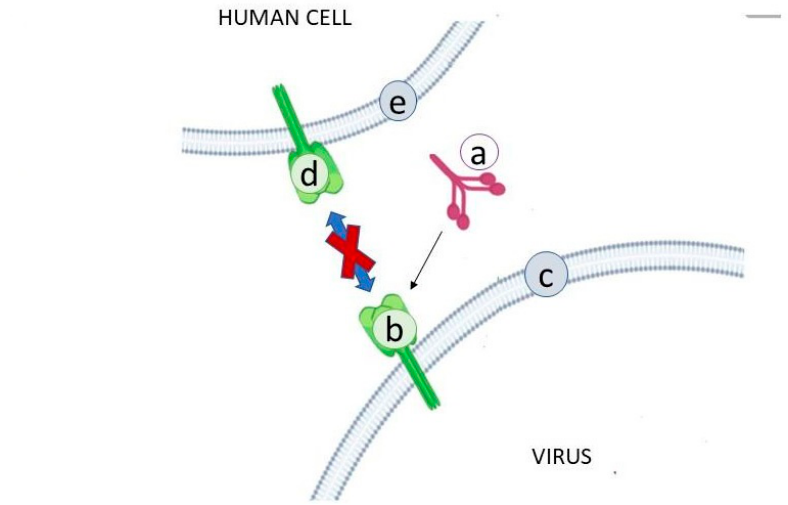
( b ) of viral envelope glycoproteins ( c ), blocking fusion with the glycan structure ( d ) of human cell Figure 1. Interaction of the lectin with the virus. The lectin (a) interacts with the high-glycan struc- membrane glycoproteins ( e ture (b) of viral envelope glycoproteins (c), blocking fusion with the glycan structure (d) of human cell membrane glycoproteins (e).